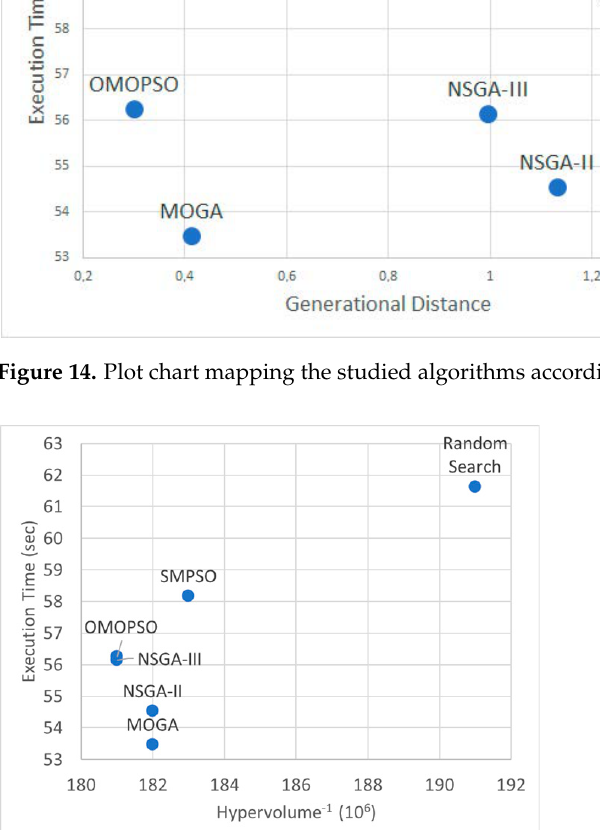
In this case, SMPSO still performs worse than the others in terms of accuracy, but much better than RS, likely due to diversity. All the rest behave similarly, the GA family